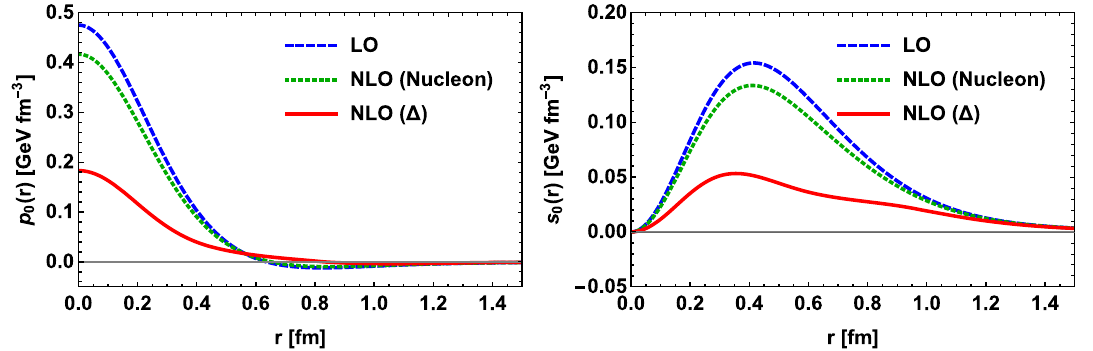
Fig. 3 The left (right) panel depicts the results for the pressures (shear forces) of the classical soliton, the nucleon, and the (cid:2) as functions of radius r . The dashed, dotted and solid curves draw the classical soliton,